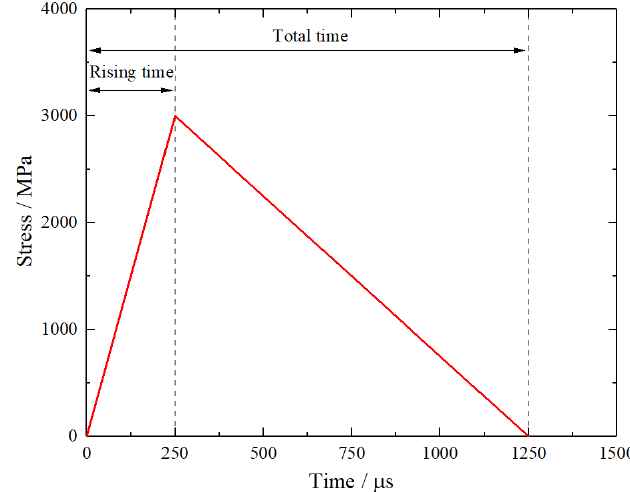
Figure 5. Blasting stress